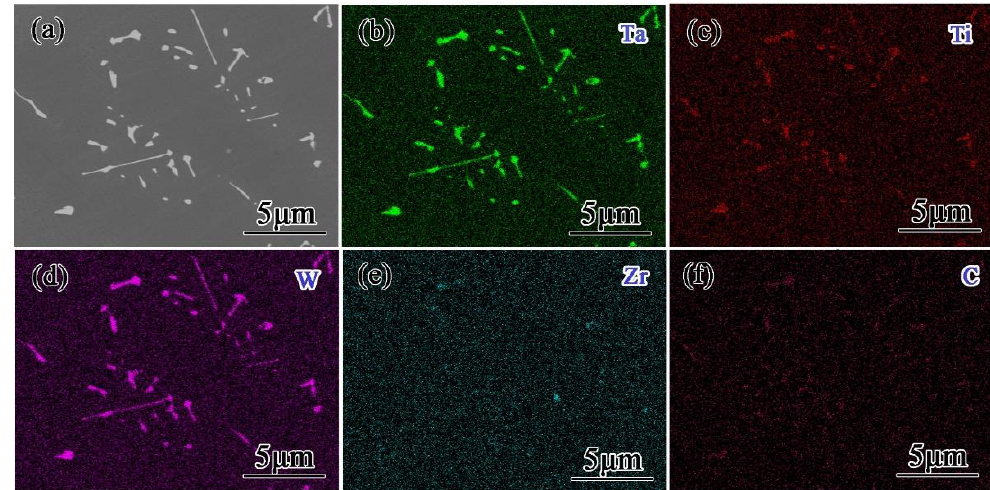
Figure 3. Chemical compositions of MC carbides: ( a ) SEM photograph; ( b ) Ta distribution; ( c ) Ti distribution; ( d ) W distribution; ( e ) Zr distribution; ( f ) C distribution. The MC carbide is rich in Ta, Ti, W, and Zr.